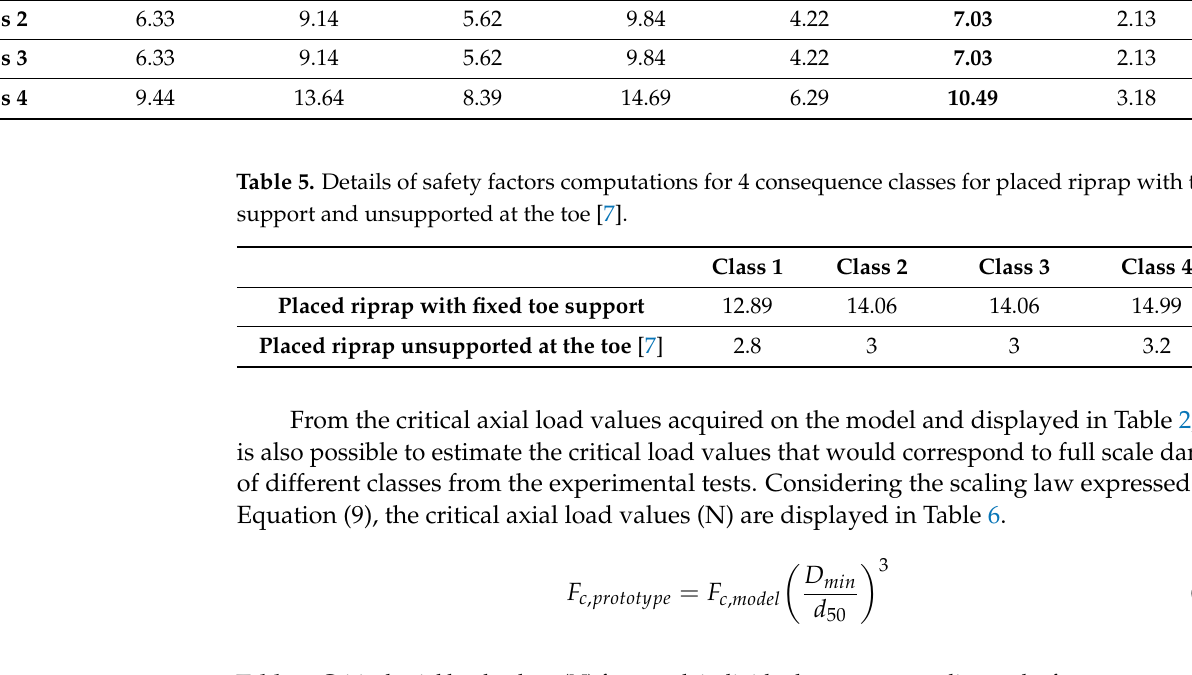
Table 6. Critical axial load values (N) from each individual test corresponding to the four consequence class dams after scaling, with associated mean and standard deviation